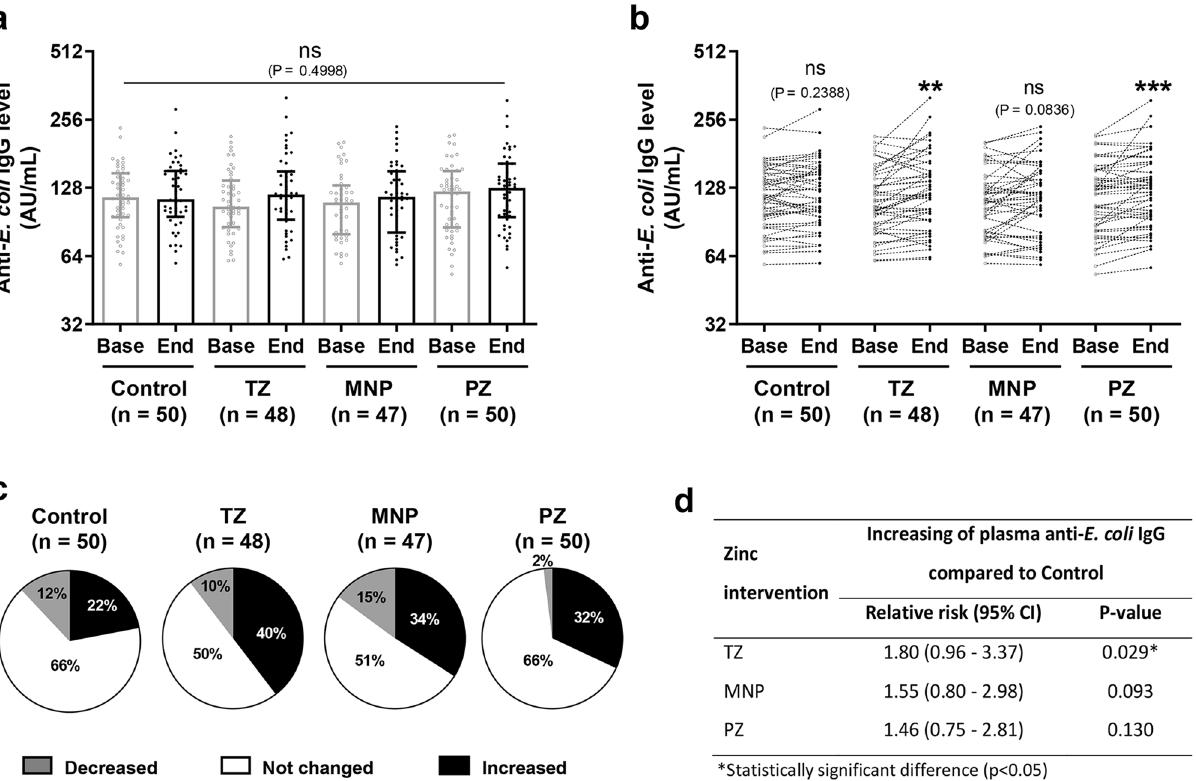
Figure 1. Plasma IgG levels in response to pathogenic Escherichia coli of the four intervention groups. ( a ) Plasma samples from baseline and endline of each intervention group (Control, n = 50; TZ, therapeutic zinc with diarrhoea, n = 48; MNP, zinc-containing micronutrient powder, n = 47; PZ, preventive zinc, n = 50) were used to determine the anti- E. coli IgG levels. The bars represent the median with the interquartile range of each group and each dot represents an individual sample. The P-value was determined with the Kruskal–Wallis test. ( b ) Changes in the antibody level in each individual. The P-values indicate significant differences between baseline and endline of each intervention group determined by the Wilcoxon matched-pairs signed rank test (**P < 0.01; ***P < 0.001; ns, non-significant). ( c ) The pie charts show the percentages of children who showed no change or an increase or decrease of at least 10% in antibody levels at endline compared with baseline for each group. ( d ) Chi-square analysis of the relative risk and P-values of increasing antibody levels for each intervention group compared with the Control